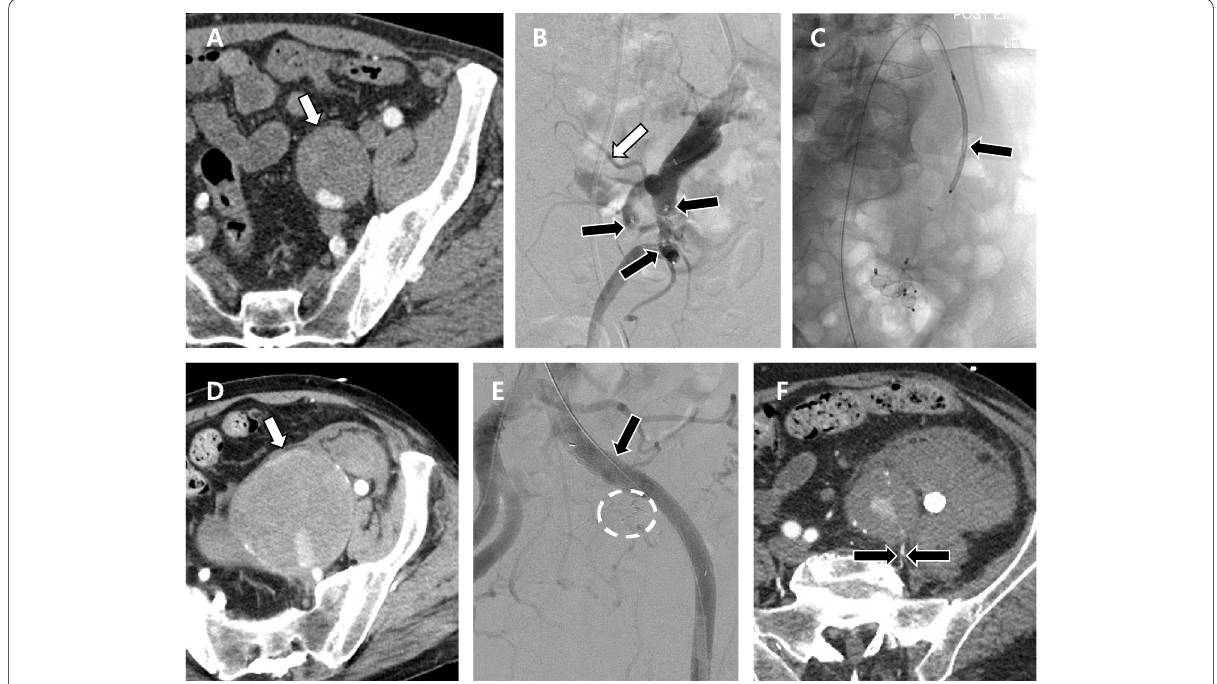
Fig. 4 Ruptured IIA aneurysm in a 63‑year‑old male resulting from persistent type 2 endoleak. A Initial CT demonstrates an isolated IIA aneurysm (white arrow) measuring 42 mm in diameter. B Vascular plugs (black arrows) were placed distally to the bifurcation of the anterior and posterior trunks of the IIA. Not a prominent iliolumbar artery (white arrow) arising proximally to the embolization site. C A vascular plug (black arrow) was placed in the proximal segment of the IIA to interrupt the inflow. D The patient returned 5 years later with a ruptured aneurysm (white arrow). E An iliac stent‑graft was deployed over the ostium of the IIA (black arrow) which had previously been embolized with a vascular plug (white circle). F Follow up CT acquired one week later demonstrates persistent endoleak associated with retrograde flow through a patent iliolumbar artery (located between two black arrows). The patient expired three weeks later from multiorgan